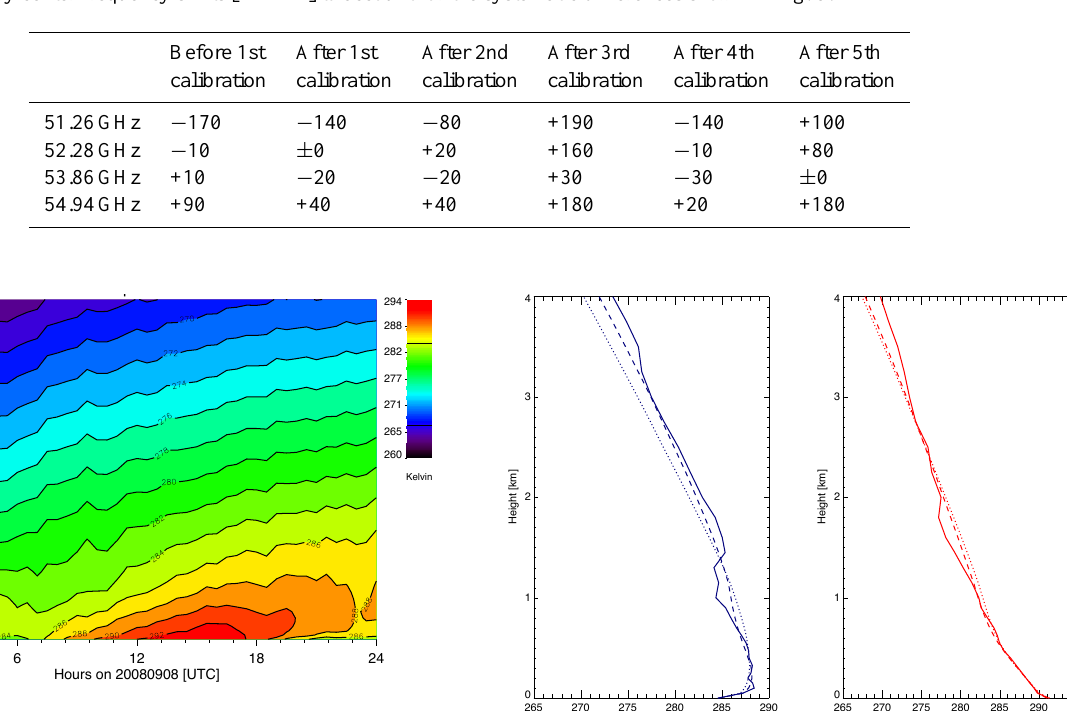
Table 4. Necessary center frequency shifts [in MHz] to account for the systematic differences shown in Fig. 3.